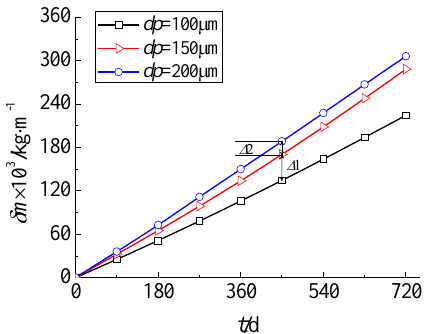
Figure 9. Global erosion loss under different ash sizes.